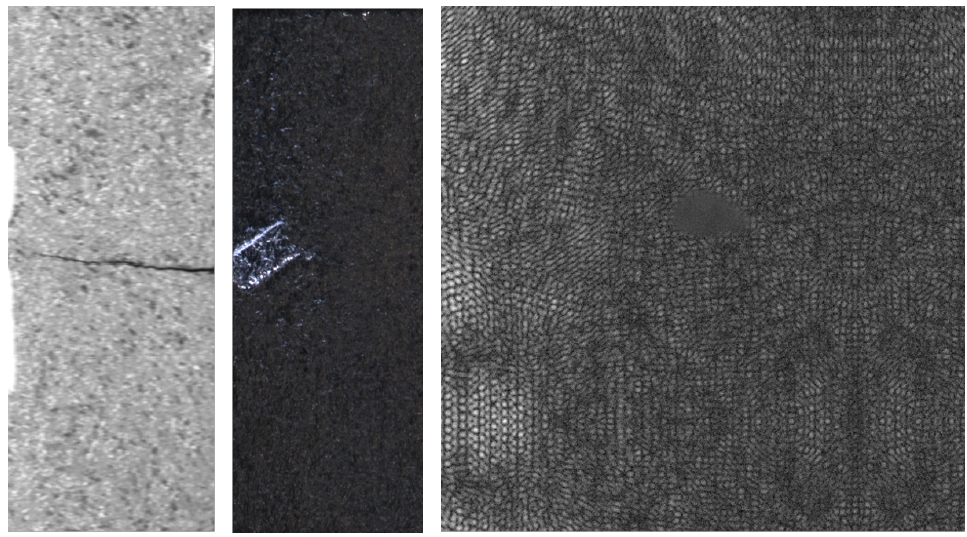
Figure 1. Examples of defect images in the three datasets